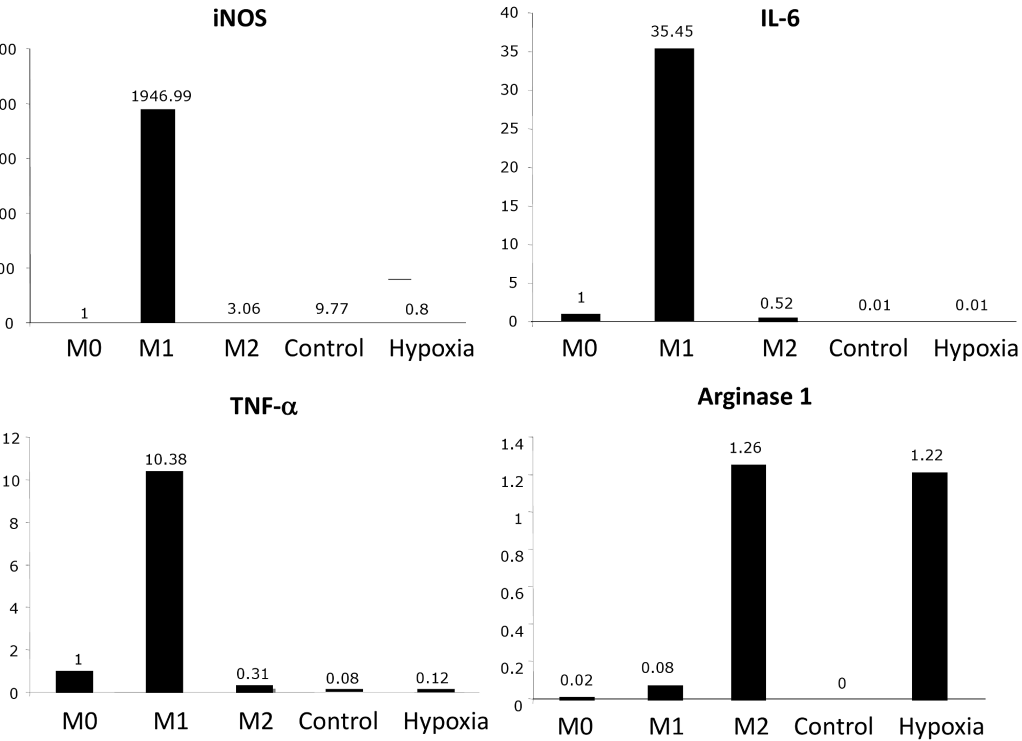
Figure 3. Hypoxic hippocampal slices trigger an alternatively-activated program in macrophages. Bone marrow-derived macrophages were cultured in the presence of control (Control) or oxygen/glucose-deprived OHCs (Hypoxia) in 6-well culture plates. Macrophages from each experimental condition were pooled and assessed by Q-RTPCR for the expression of the following genes: inductible nitric oxide synthase (iNOS), IL-6, TNF- a and Arginase-1. As controls, analyses were performed in parallel on mRNAs extracted from M1 macrophages (stimulated with IFN- c ), M2 macrophages (stimulated with IL-4) or M0 macrophages (non-stimulated). Data showed that, as expected, iNOS and the pro-inflammatory cytokines IL-6 and TNF- a were highly expressed in M1 macrophages as compared to M0 or M2 macrophages. With regard to these M1-type pro-inflammatory genes, bone marrow-derived macrophages co-cultured with oxygen/glucose-deprived OHCs (Hypoxia) exhibited low levels of mRNA expression and a similar profile to bone marrow-derived macrophages co-cultured with control OHCs (Control). In contrast, the M2-type gene Arginase-1 was highly expressed in hypoxic macrophages (co-cultured with oxygen/glucose-deprived OHCs) as compared to control macrophages (co-cultured with control OHCs). As expected, Arginase-1 was also highly expressed in M2 macrophages as compared to M0 or M1 macrophages. Data shown are representative of two independent experiments.